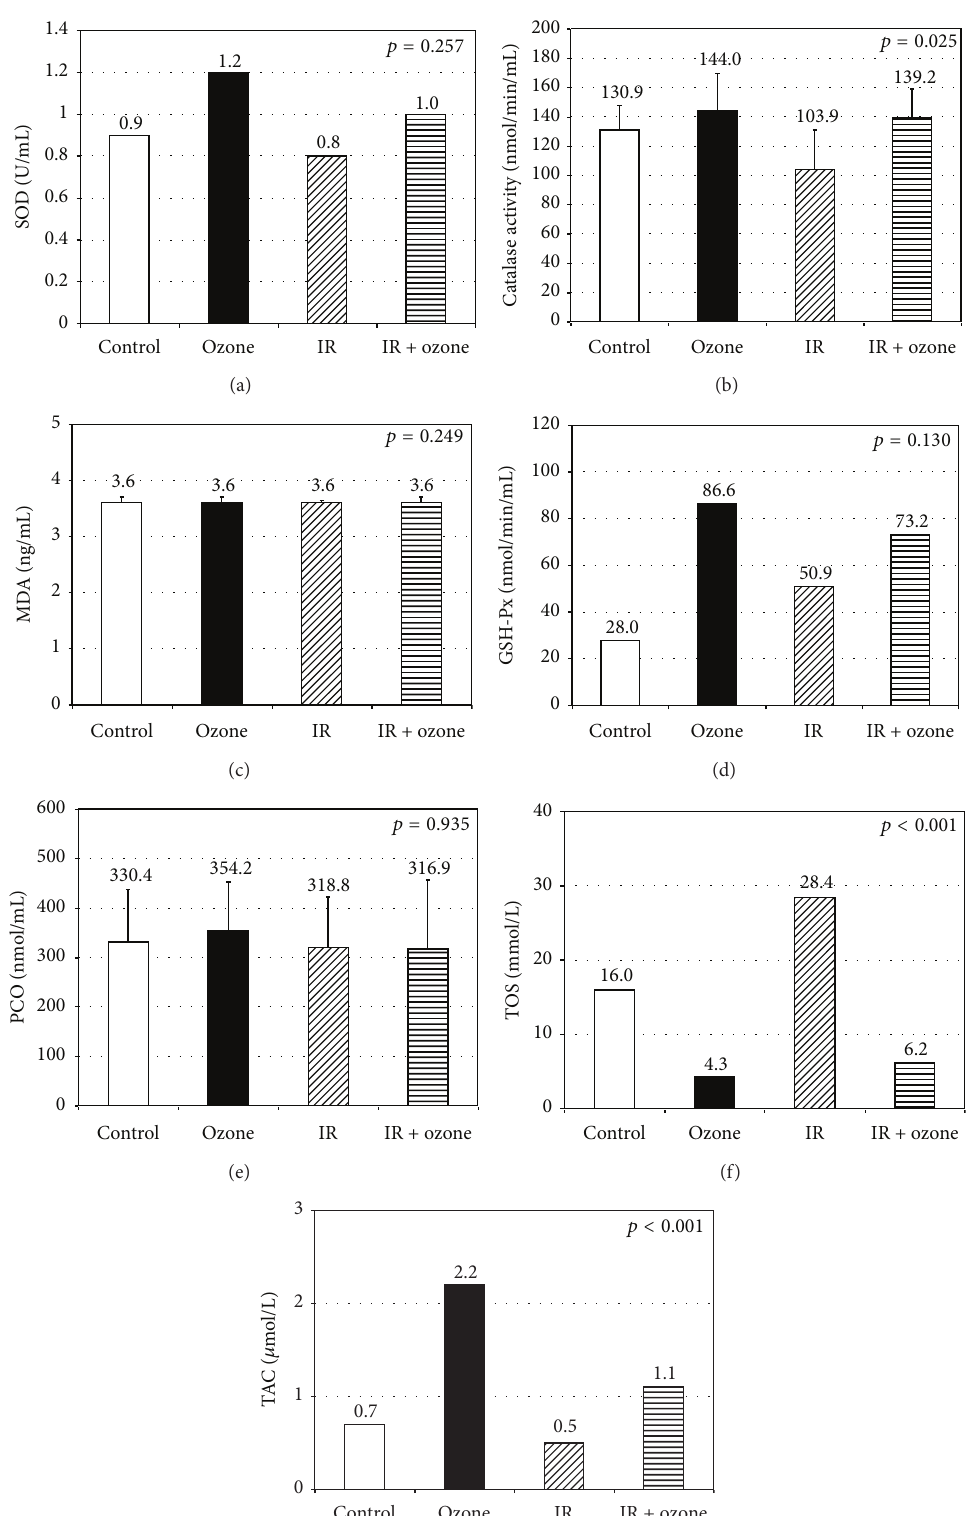
Figure 3: Biochemical measurements regarding the study groups. The white and black bars represent control and Ozone groups, respectively. The hatched bars represent the situation after IR injury (diagonal lines). The hatched bars represent the situation after Ozone exposure (horizontal lines) prior to intestinal IR